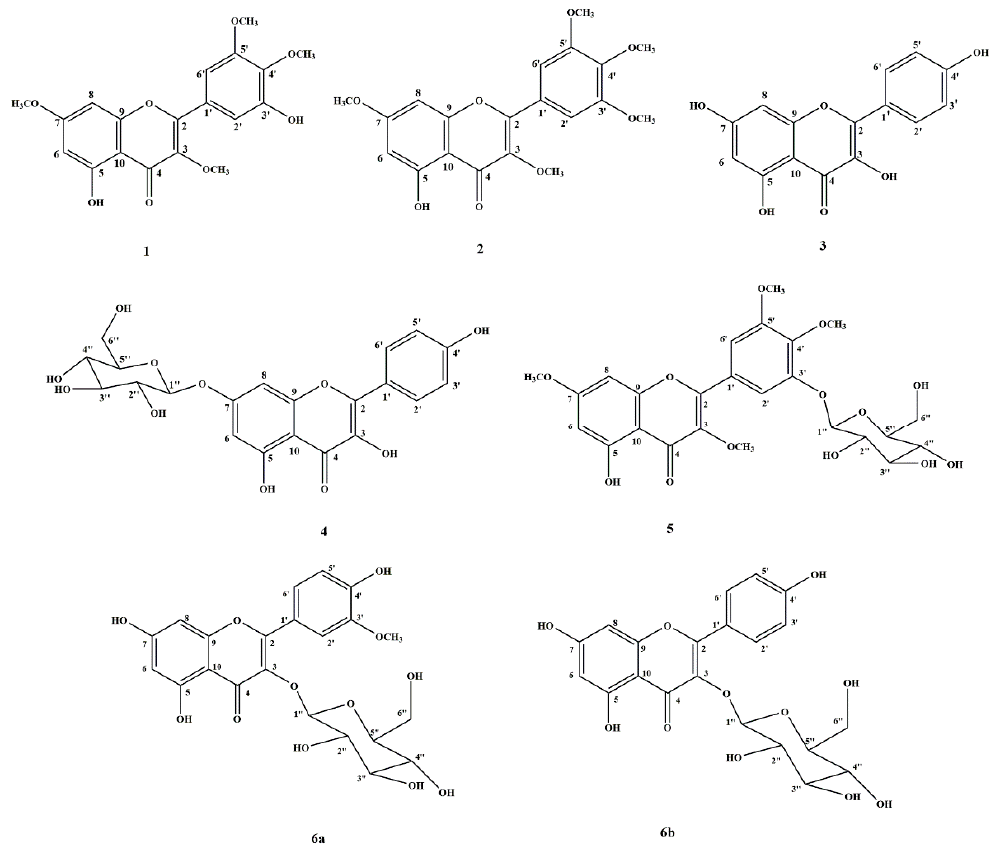
Figure 2. The isolated compounds from S. stramonifolium